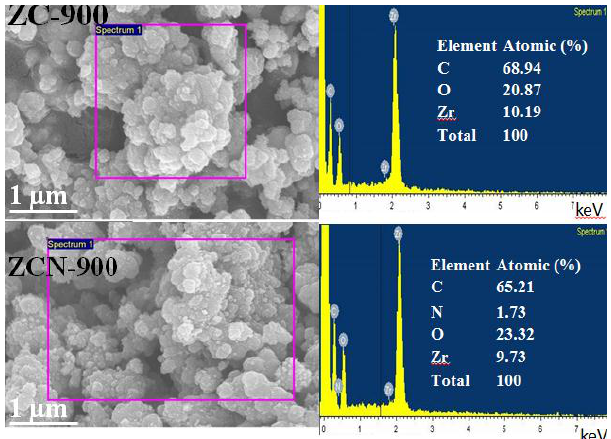
Figure 4. Images of ZC-900 and ZCN-900 obtained using field emission scanning electron microscope coupled with energy-dispersive X-ray spectroscopy (FE-SEM/EDS).